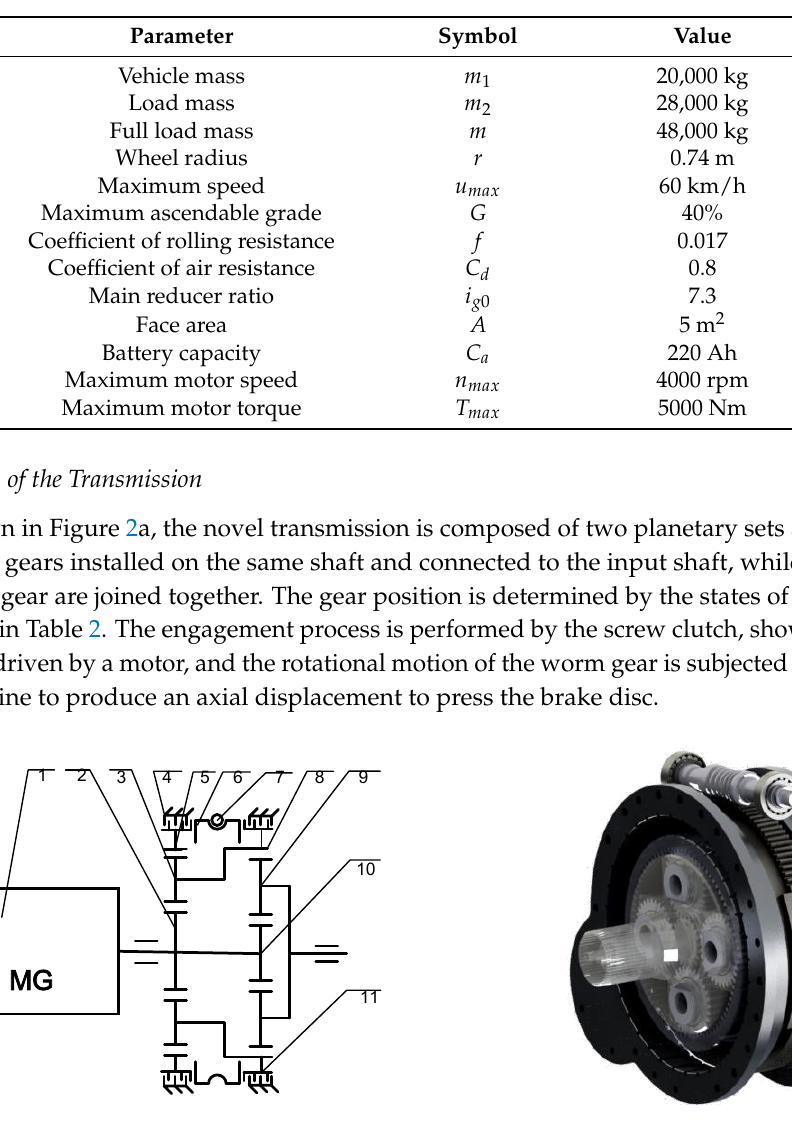
Table 1. Basic parameters of the electric dump truck (EDT).